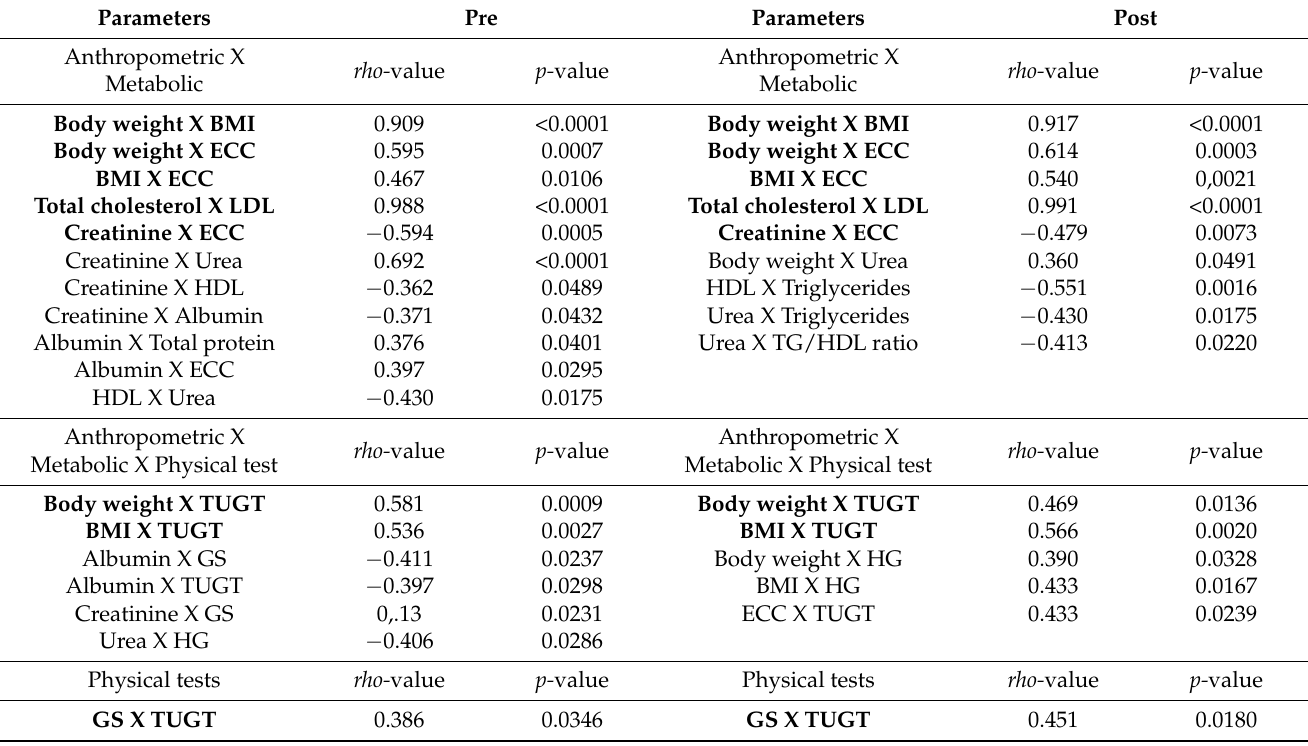
Table 3. Significant results obtained in the Pearson’s coefficient correlation analysis among all parameters assessed both before (pre) and 12 months after (post) social isolation imposed in response to the COVID-19 pandemic. Bold text indicates parameters assessed both pre- and post-COVID-19 pandemic